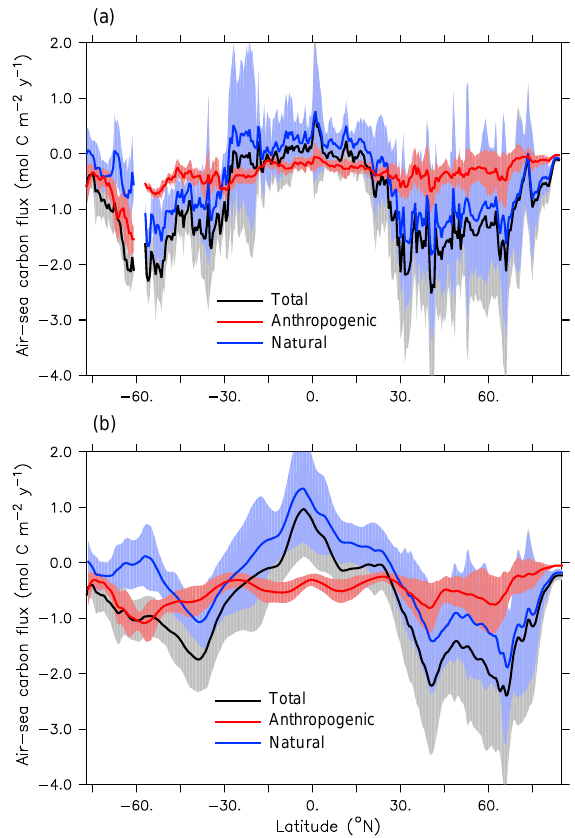
Figure 5. Zonal-mean, sea-to-air fluxes of total, anthropogenic, and natural CO 2 (molCm − 2 yr − 1 ) given as the average over 1993–2012 for (a) the coastal ocean and (b) the global ocean. Shaded areas indicate the standard deviation of environmental variability of all ocean grid cells within each latitudinal band. Interannual variations are not shown.